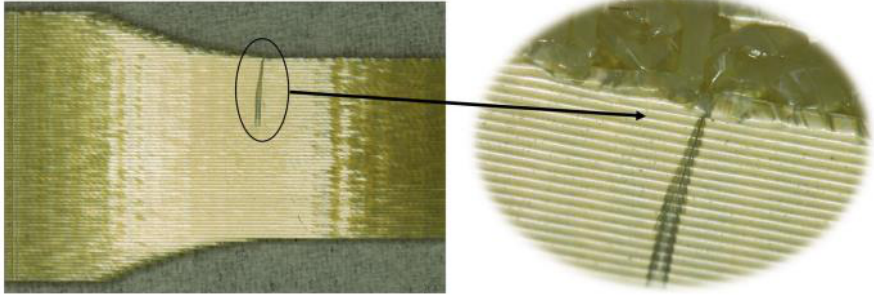
Figure 8. Tensile fatigue cracks initiating from the shoulder area of an Ultem 9085 print (Reprinted with permission from [36]. Copyright 2016, Springer Nature).